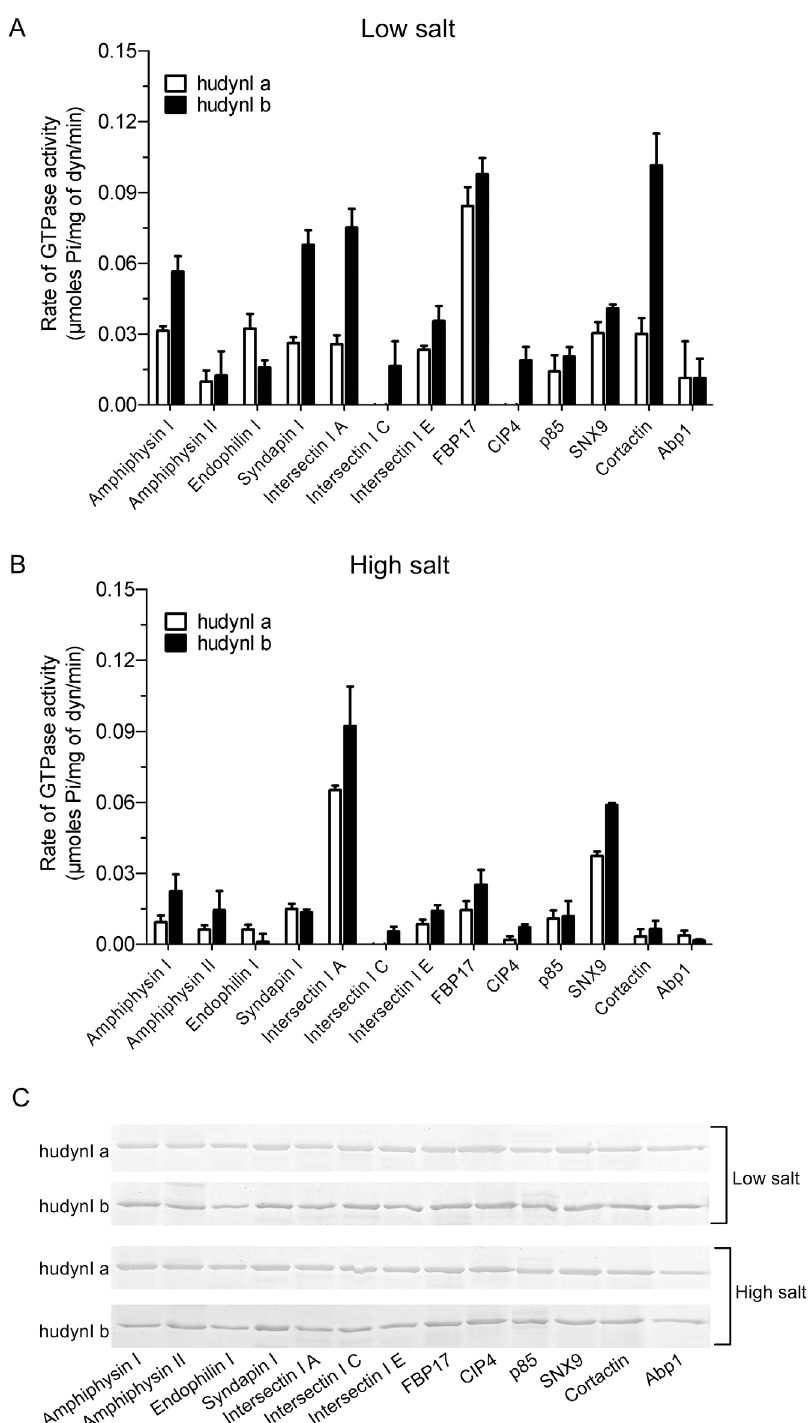
Fig 2. Stimulation of the dynamin GTPase activity by SH3 domains is determined by its middle domain. Effect of GST-SH3 domains (40 μ g/ml) on the GTPase activity rate of purified recombinant human dynamin I middle domain splice variants ab and bb (hudynI a and b, both at 100 nM / 10 μ g/ml) determined using ELIPA. The assays were performed in the presence of low salt (30 mM NaCl) (A) or high salt (150 mM NaCl) (B) . All data is shown as means ± S.E.M. and n (cid:1) 2. (C) The relative binding of dynamin to individual GST-SH3 domains (~12 μ g) was compared by performing pull-down analysis using purified recombinant